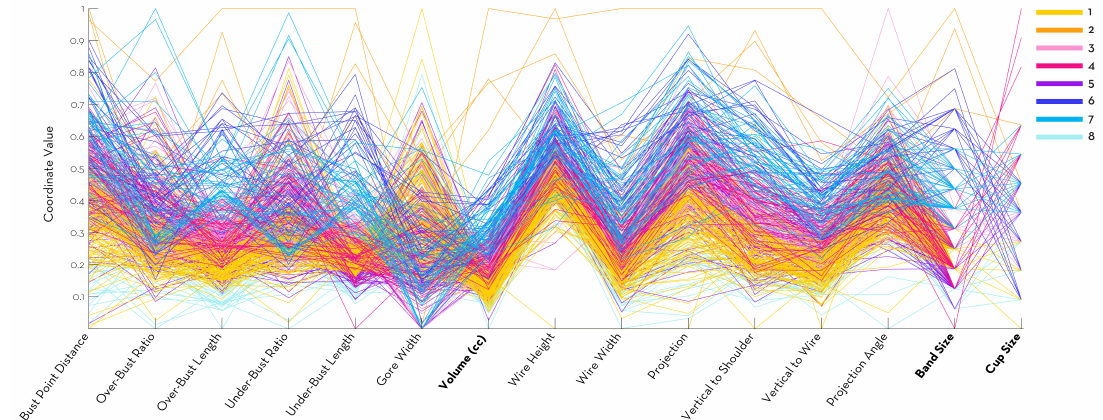
Figure 14. Parallel coordinate plot of measurement data, colored according to clusters.